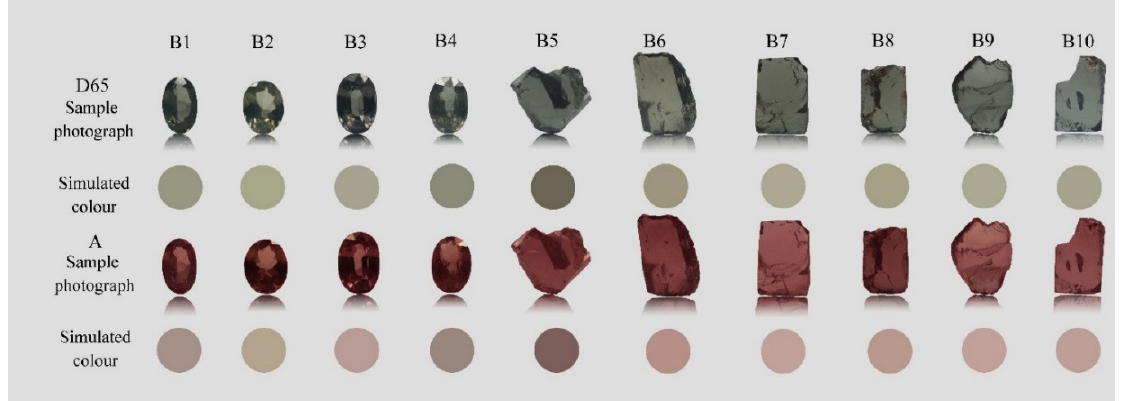
Figure 7. Fashioned gems and the corresponding simulated colours calculated by using the colour matching functions.